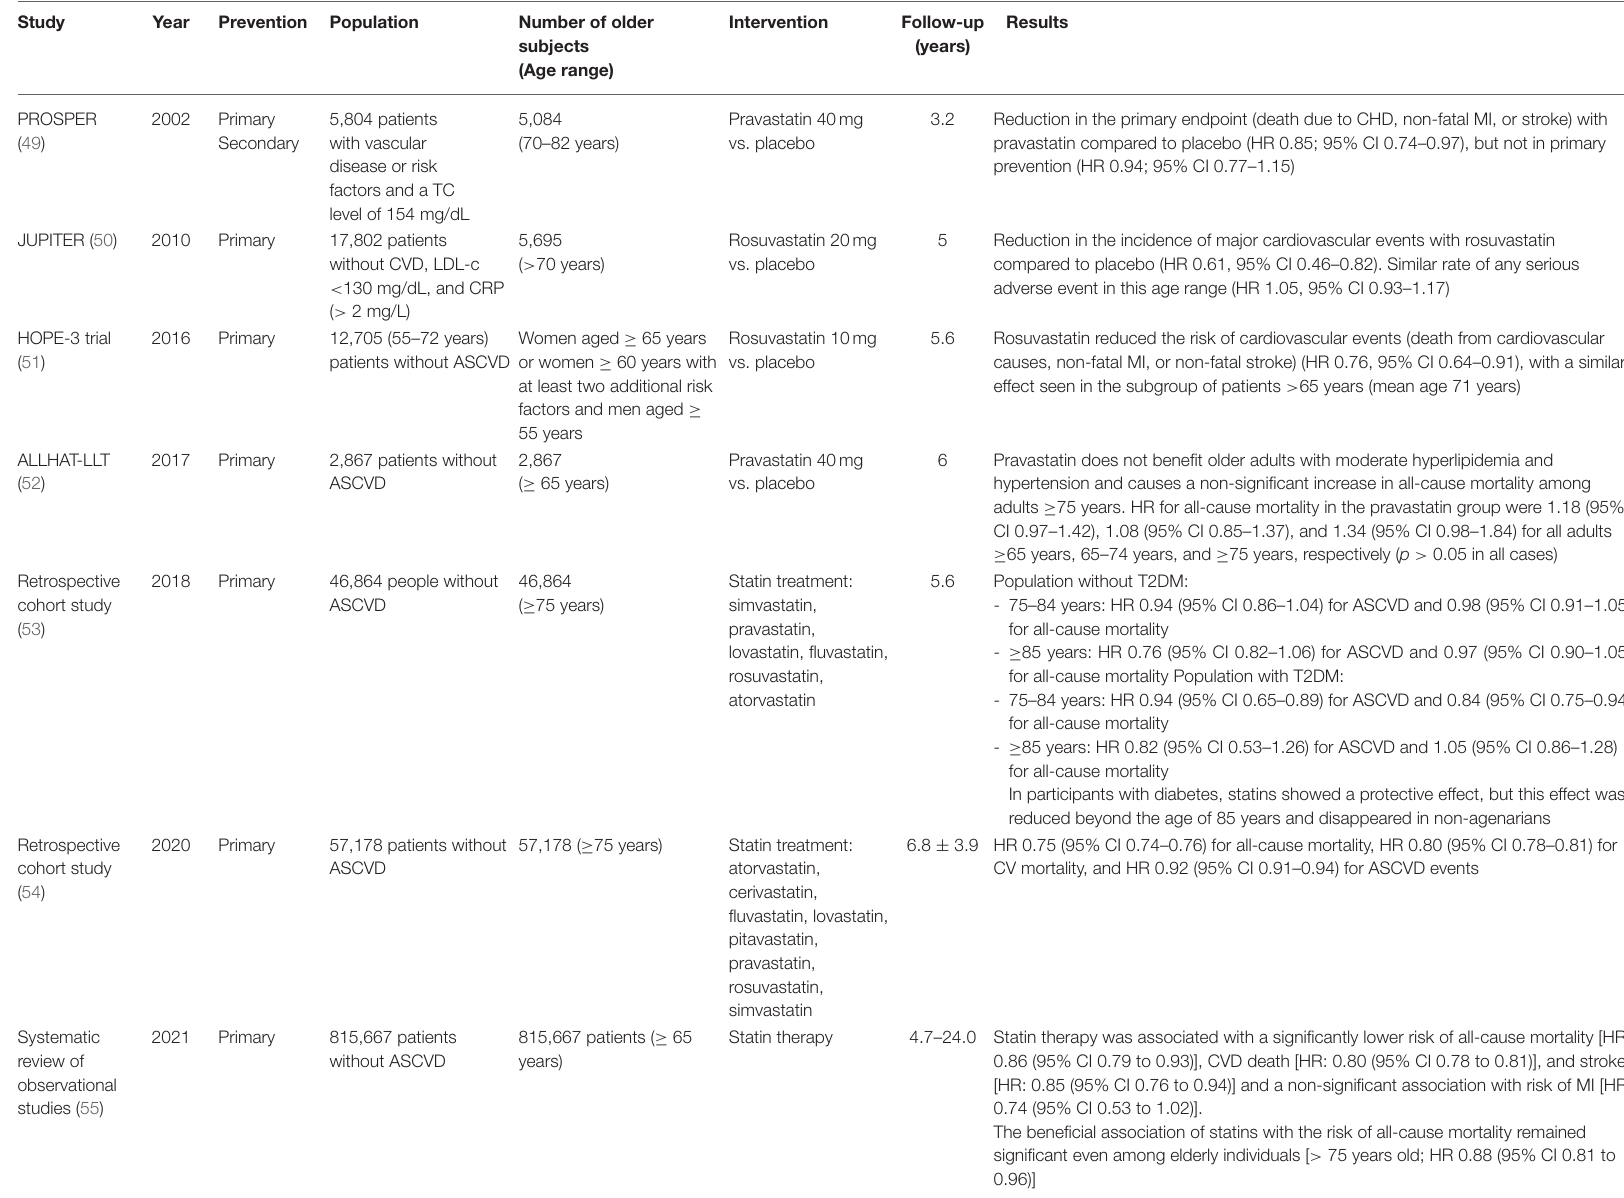
TABLE 1 | Available studies on statin use for primary and secondary cardiovascular prevention in older subjects.